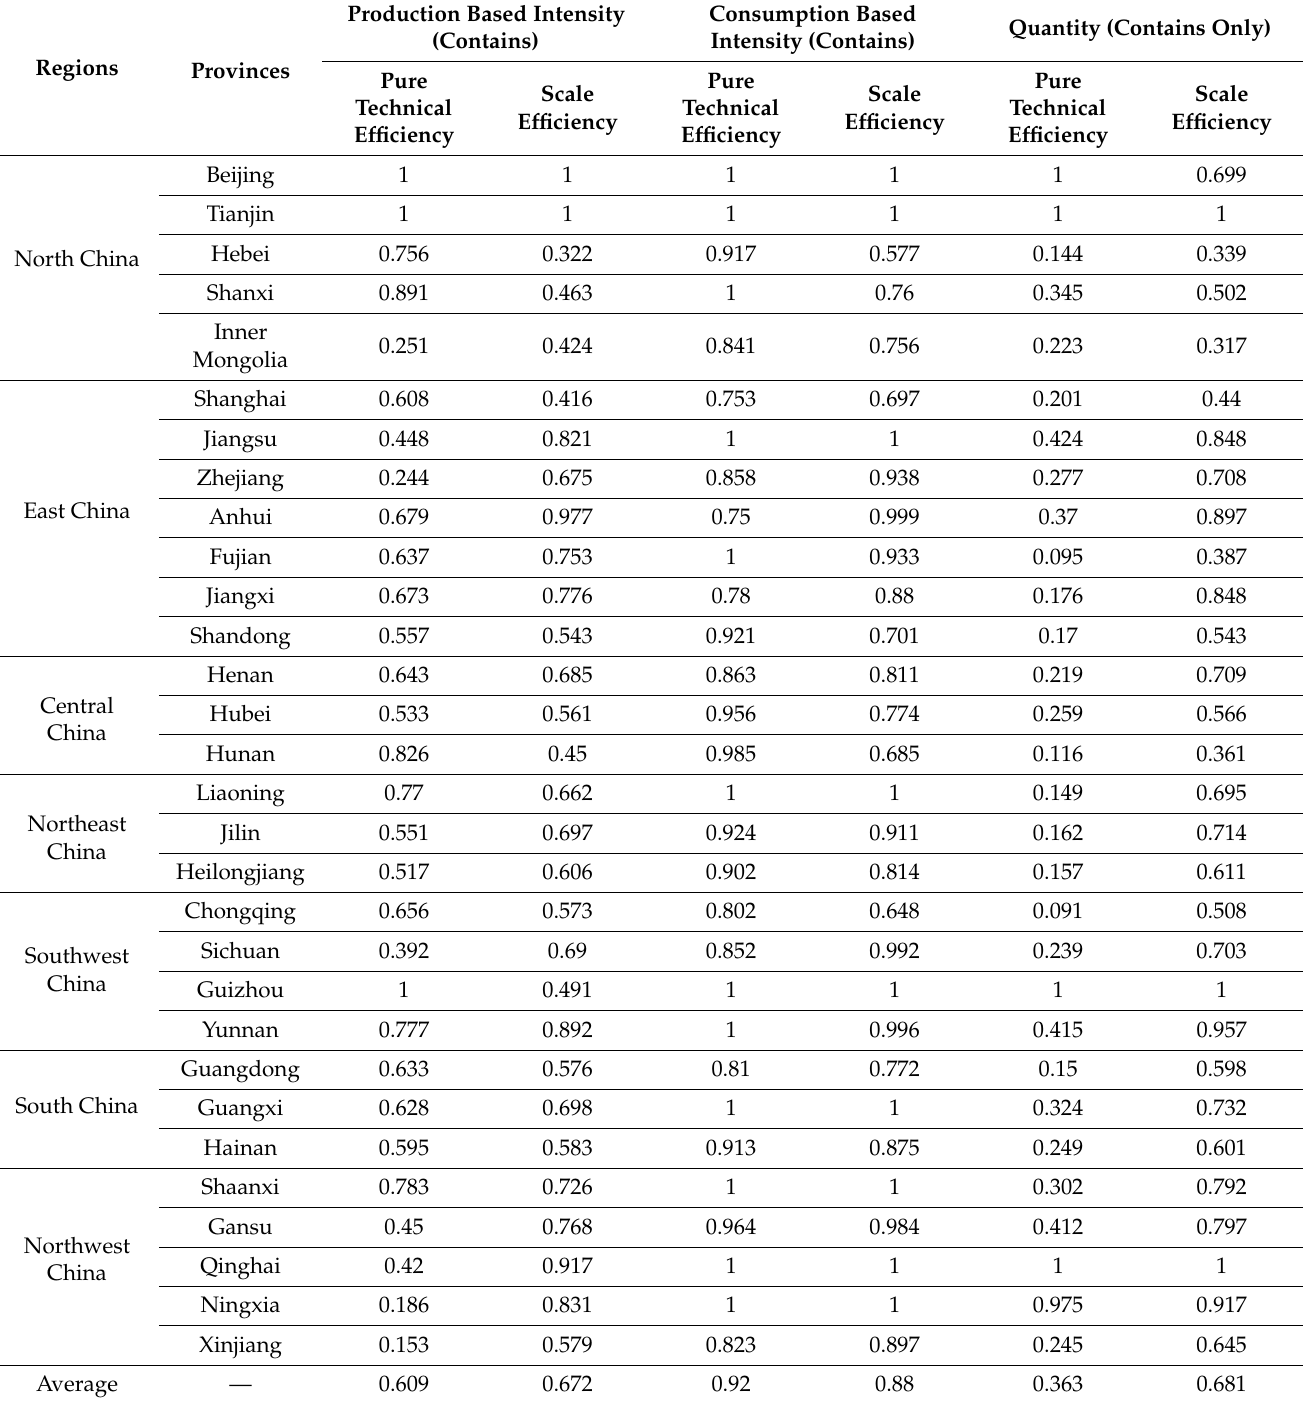
Table 3. Calculation results of the pure technical efficiency and scale efficiency of WEF input–output in 30 provinces of China in